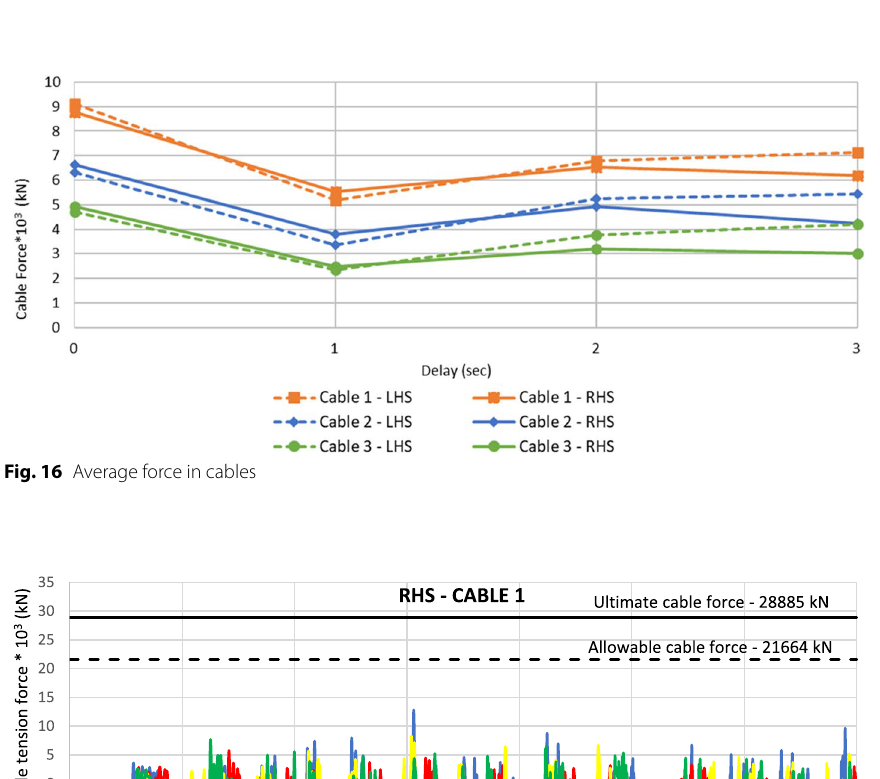
Fig. 15 Maximum force in cables under different earthquakes